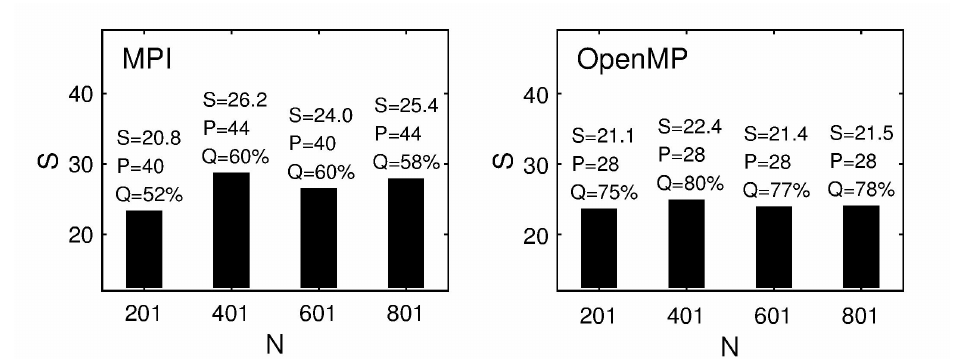
Figure 1. Maximal speedup S versus the number of coordinate nodes N in case of the MPI (left) and OpenMP (right) parallel